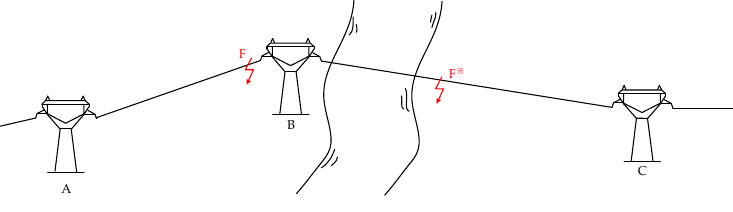
Figure 2. Schematic diagram of a tower across a river.